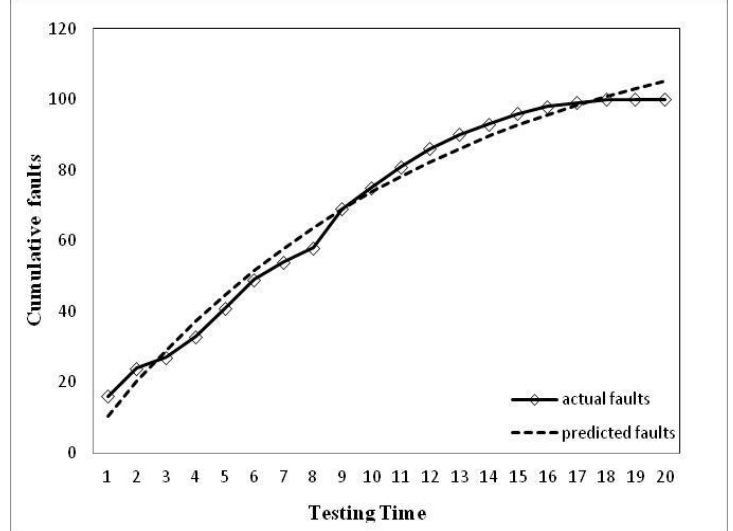
Figure 2. Actual versus predicted fault count of Tandem computers first release